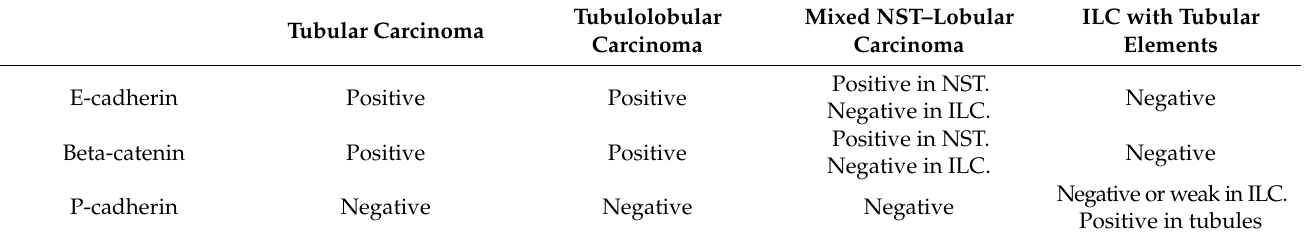
Table 9. Immunohistochemical characteristics of invasive lobular carcinoma with tubular elements and its differential